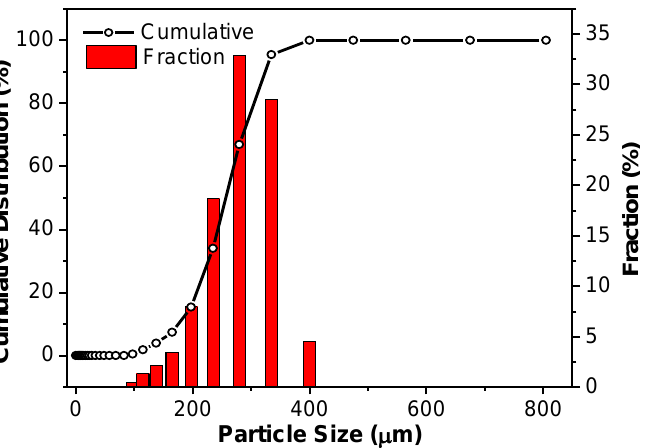
Figure 4. DL‑MC particle size Figure 4. DL-MC particle size distribution.